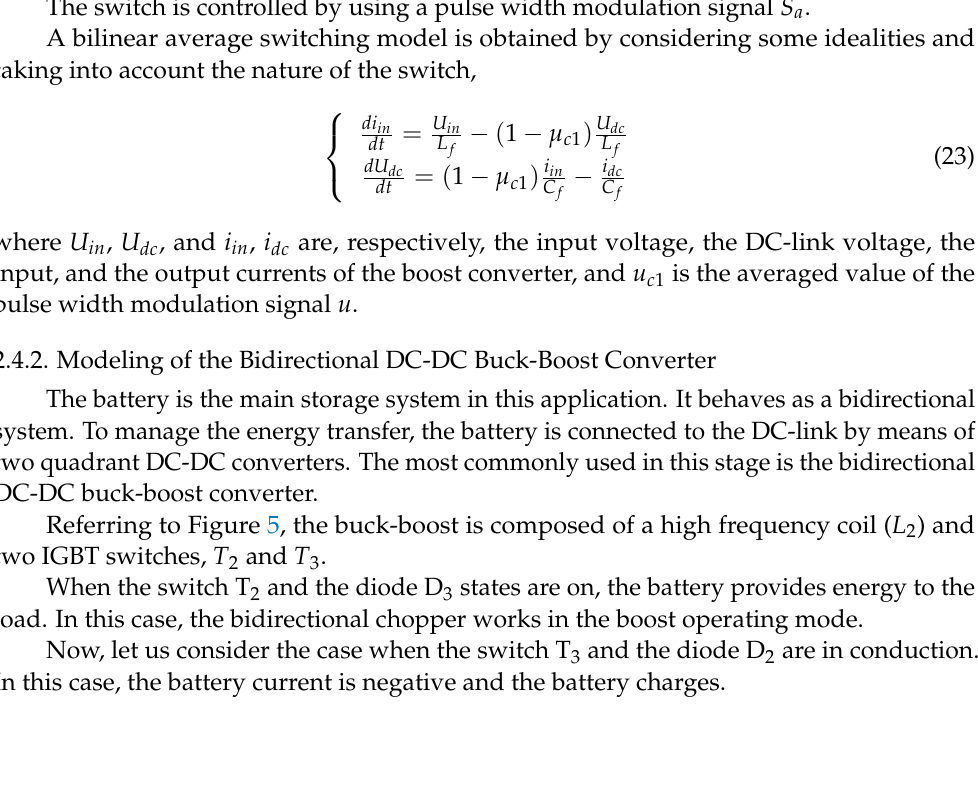
Figure 5. Bidirectional buck-boost chopper.